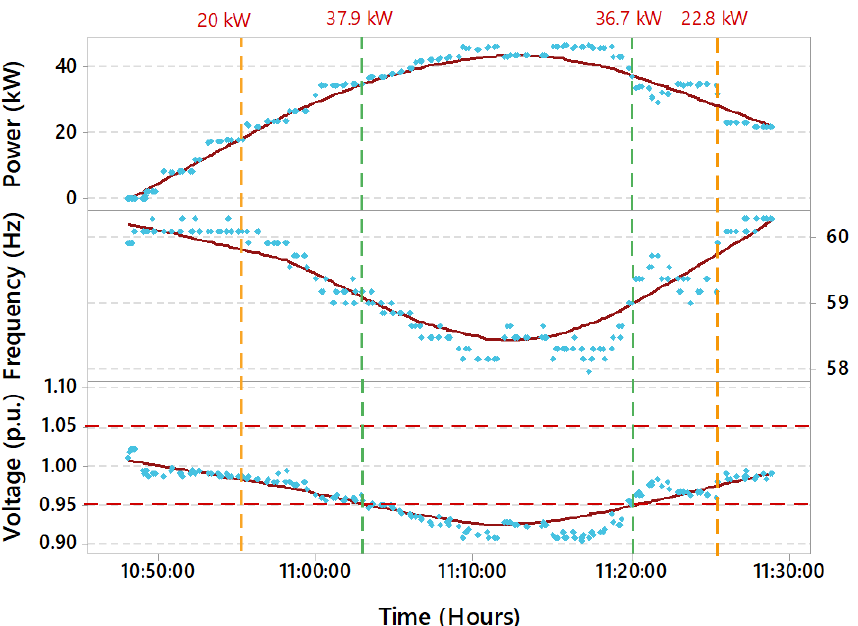
Figure 19. Power, voltage and frequency comparation of diesel generator set in off-grid conditions.